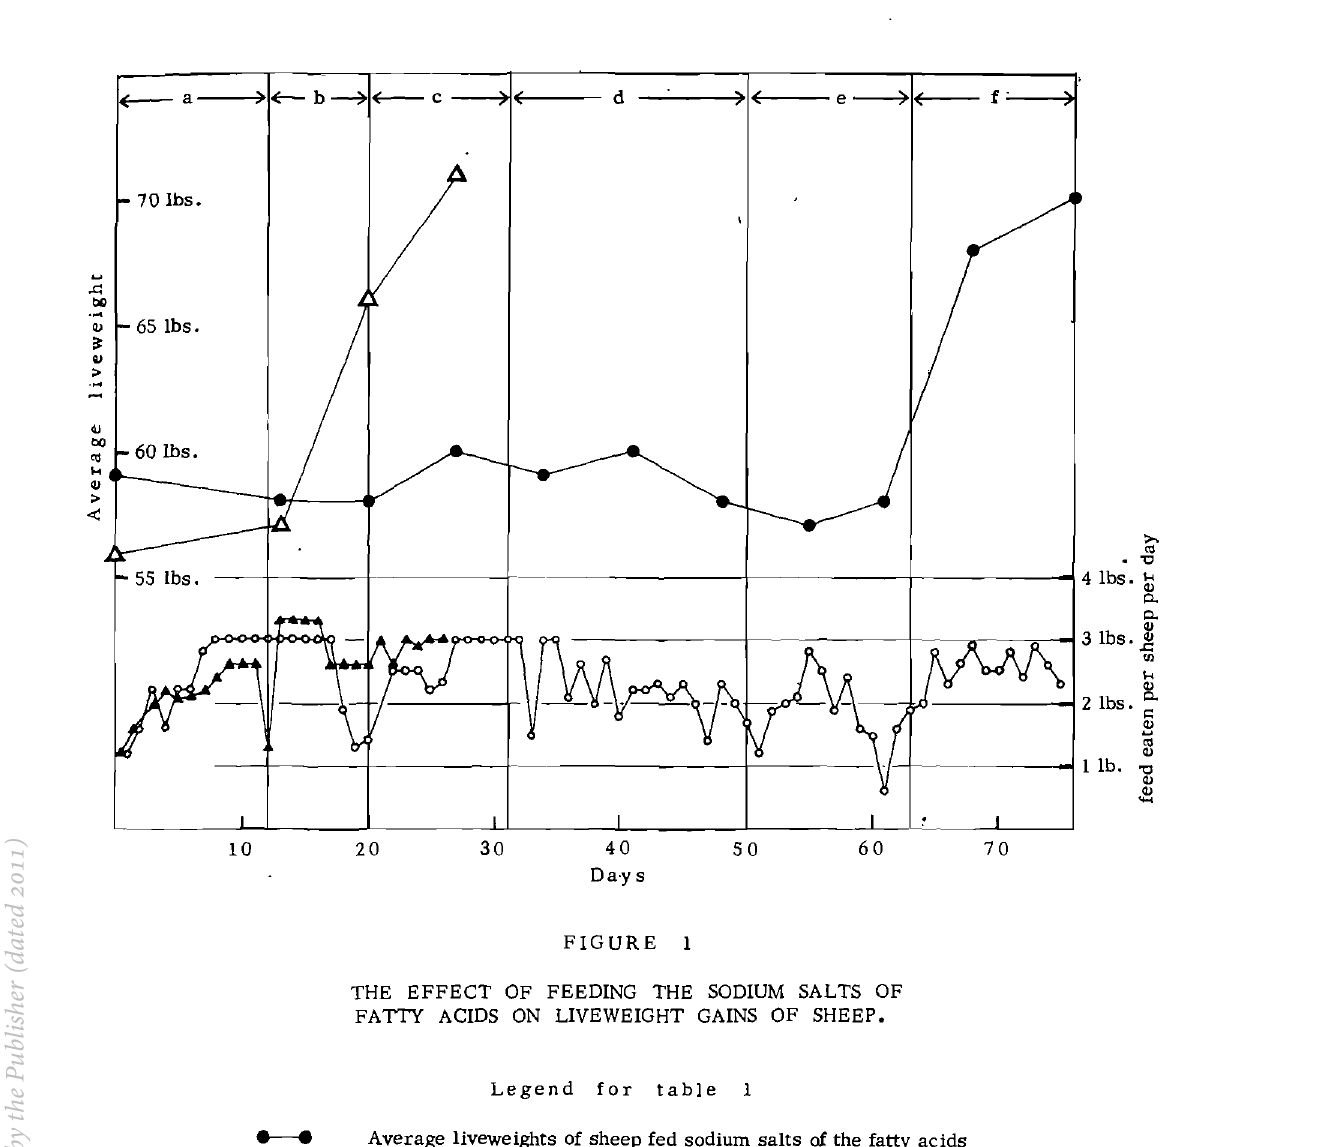
Legend for 1 Average liveweights of sheep fed sodium salts of the fatty acids (pen 13 ) Average liveweight of sheep not receiving fatty acid salts (pen 14 ) Average daily feed eaten by sheep receiving fatty acid salts (Pen 13 ) Average daily feed eaten by sheep not receiving fatty acid salts (pen 14 ) Day 1 - 12 no salts in feed of treated group 0.44 to 2.44 Ths. of salts in 13 Ths. feed presented - 30 2. 2 Ths. salts in 15 Ths. feed presented